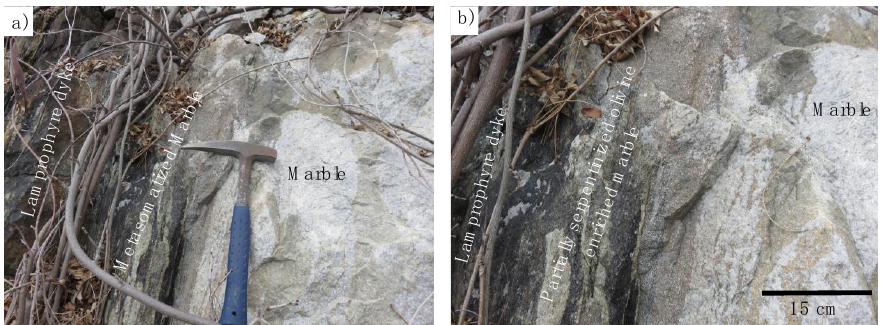
Figure 2. Representative field photos of the lamprophyre dyke–marble contact from the south-western Korean Peninsula in the Hongseong-Imjingang belt. ( a ) Light greenish metasomatized region at the contact zone. ( b ) Enlarged photo of the contact zone showing a light greenish to light brownish partially serpentinized olivine-enriched region. The highly serpentinized area (with minor olivine) is relatively fine-grained and appears dark compared to the medium-grained olivine-bearing portions. A total of nine samples were systematically collected from a road-cut outcrop, exposing a metasomatized zone comprising a lamprophyre dyke ~1 m in width (Figure 3). Three samples of lamprophyre dyke were collected from this dyke at distances 0.5 m apart (Figure 3a). We avoided sampling close to the contact zone in order to obtain the original composition of the lamprophyre dyke. Three olivine-bearing samples (0.5 m apart from one another) were also collected from the partially serpentinized, olivine-enriched area (Figure 3b). Again, three marble samples were collected, 0.5 m apart, ~1 m away from the metasomatized region (Figure 3c). From these samples,